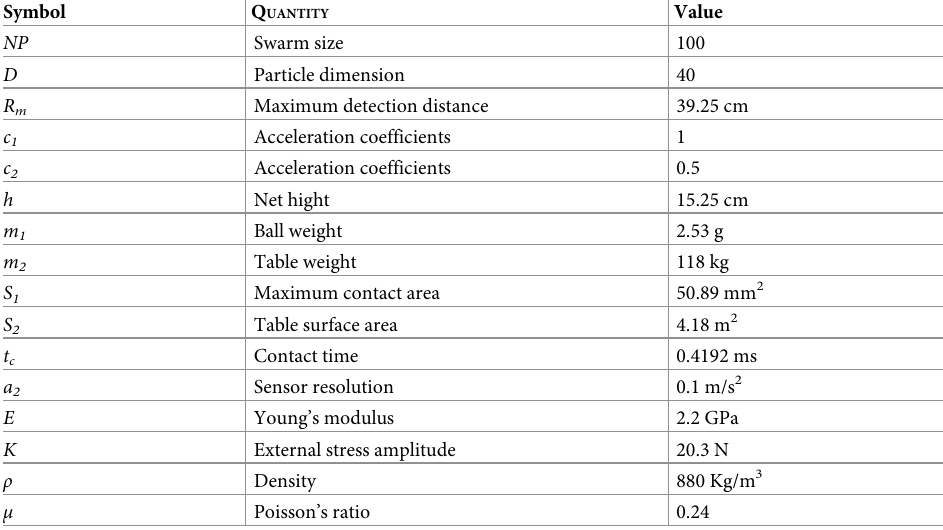
Table weight Table surface